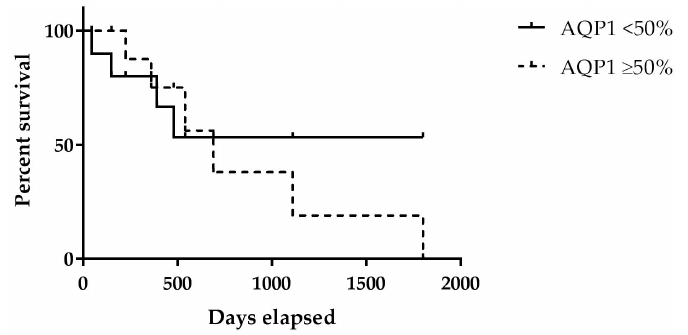
Figure 3. Kaplan-Meier survival curve of aquaporin-1 (AQP1) expression in fluoro-edenite (FE)- induced mesothelioma patients. Table 2. Univariate and multivariate analysis for aquaporin-1 (AQP1)